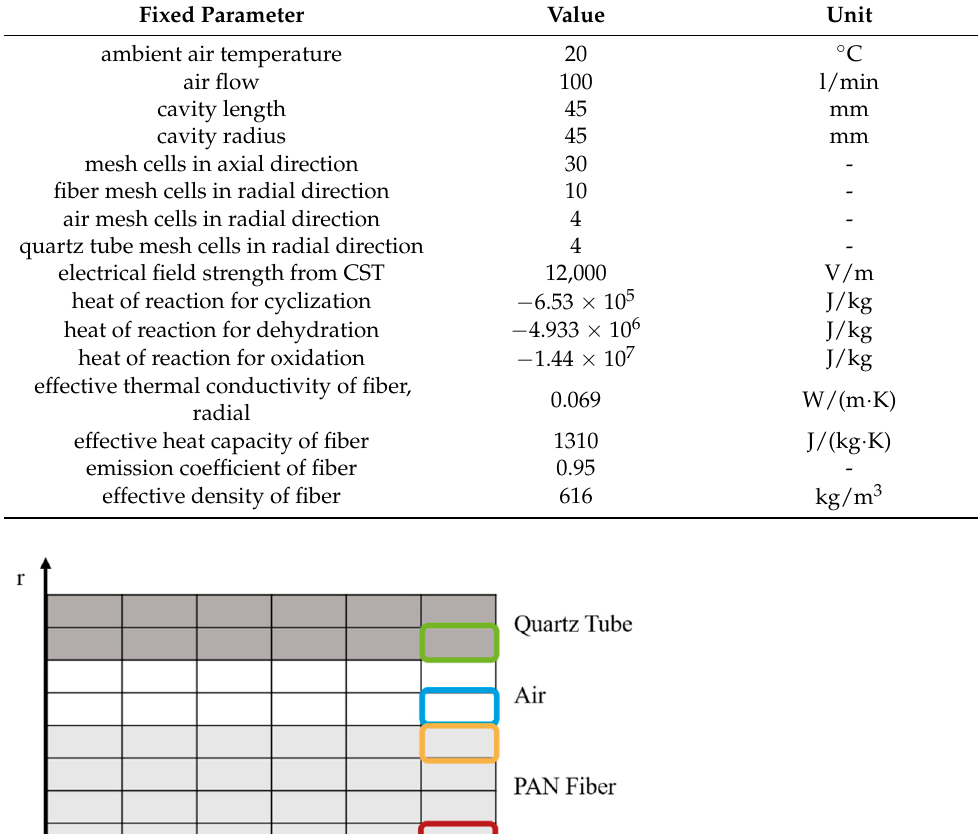
Table 2. Model input parameter values for the temperature calculation of a batch process.